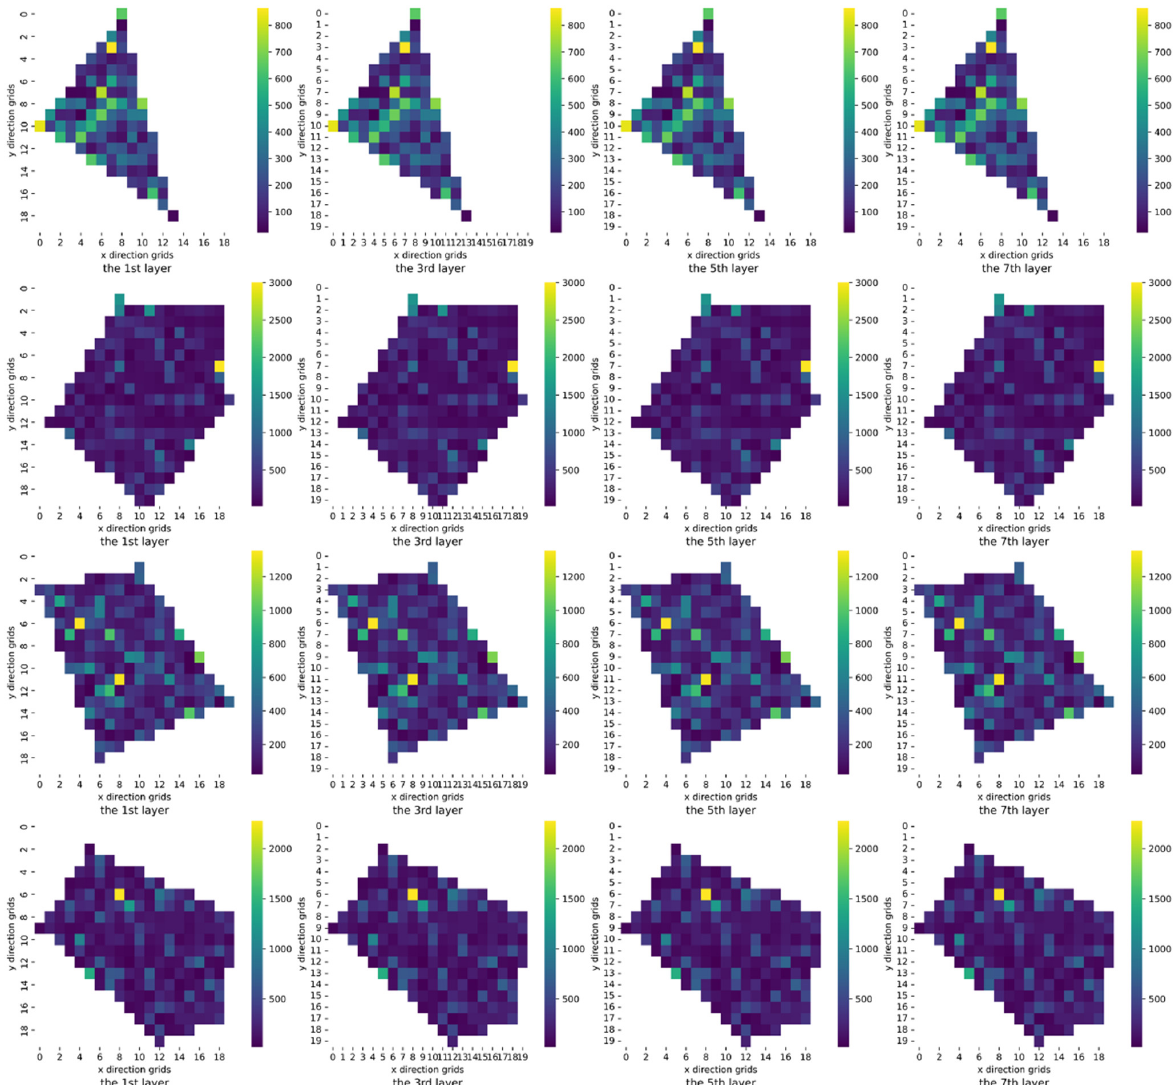
Figure 7. The permeability distribution of 5 random samples (each row represents the permeability of the first five layers and each sample contains eight layers in total).